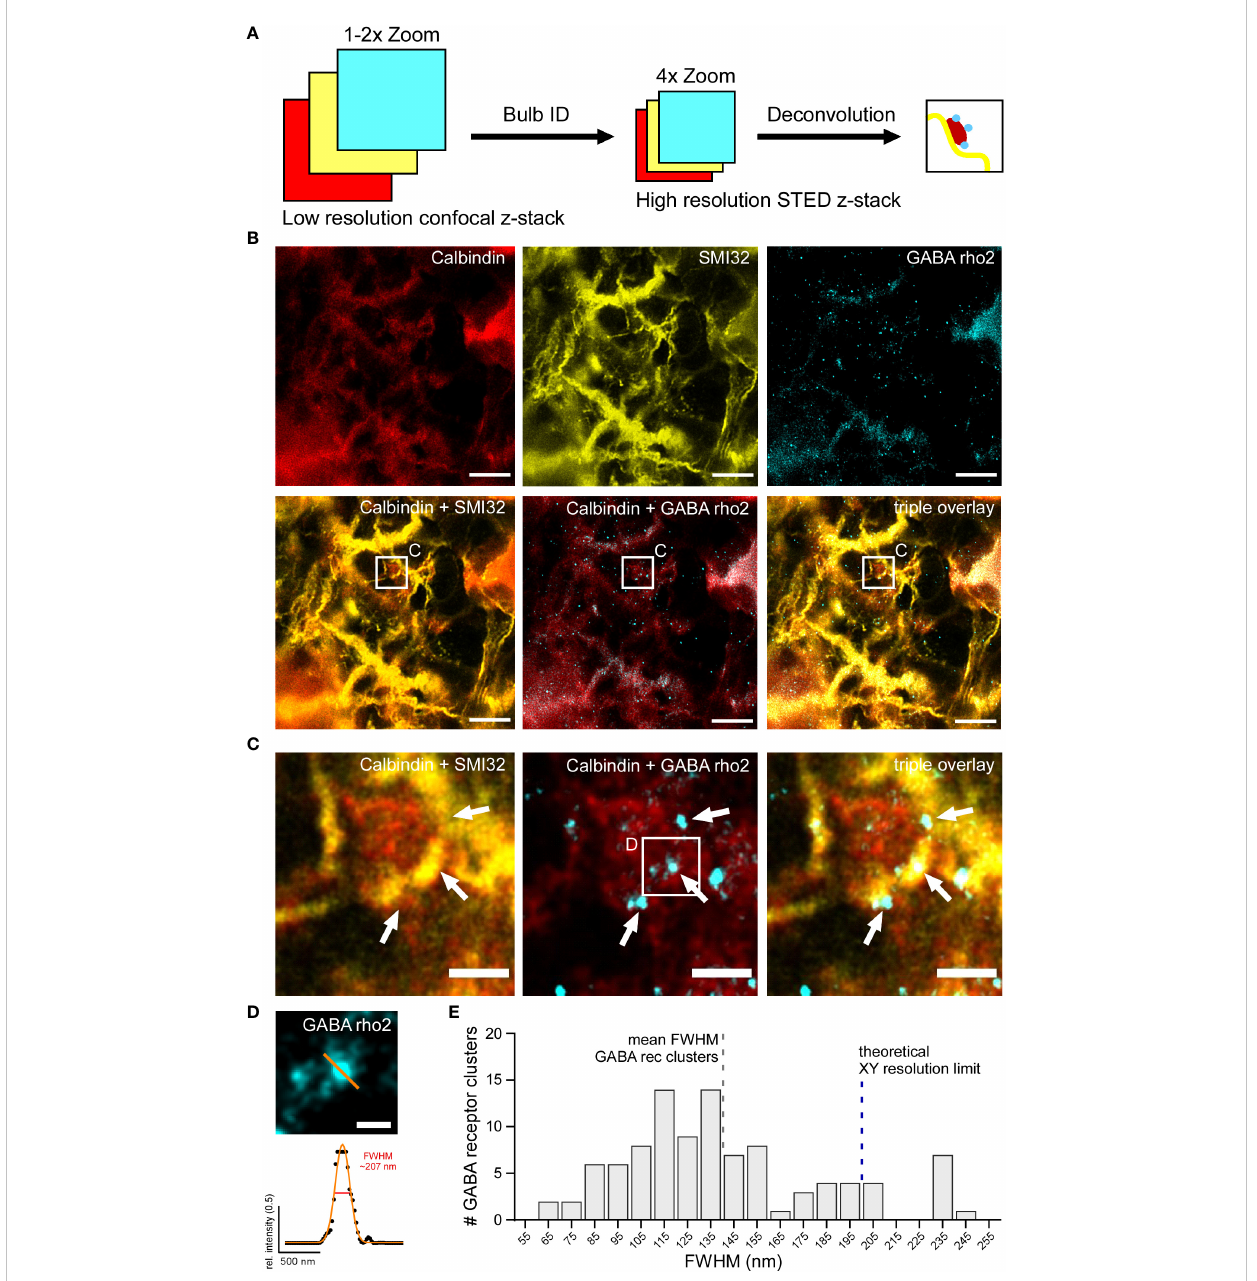
FIGURE 8 GABA C receptor clusters can be localised on horizontal cell dendritic bulbs with high-resolution STED (A) Schematic showing experimental design to image dendritic HC bulbs with high-resolution STED microscopy. Individual bulbs are identi fi ed in sections of large confocal z-stacks (Bulb ID, see also Figure 3). Bulbs were zoomed into, imaged as STED z-stacks and visualised using maximum z-projections and deconvolution. (B) Triple staining experiment against Calbindin (red), SMI32 (yellow) and GABA r 2 (cyan) showing a dendritic bulb (white square) imaged in the STED mode. The centre of the bulb is negative for SMI32 but positive for calbindin labelling. White square indicates the position of the bulb depicted as close-ups in C. (C) Zoomed-in bulb with triple staining against Calbindin, SMI32 and GABA r 2 showing a HC dendritic bulb (from white square in B) imaged in STED mode and deconvolved. Note that GABA r 2 receptor clusters (arrows) are located at the edges of bulb. (D) Example r 2-positive GABA receptor cluster (top, small white square from C) with Gaussian fi t and FWHM (bottom). FWHM intensity pro fi le is taken at the indicated position (orange line). (E) Histogram showing distribution of FWHMs of GABA r 2 clusters (in 10 nm bins) (n = 1 animal, n = 100 clusters). Dashed blue bar indicates xy resolution limit for confocal light microscopy (~ 200 nm), dashed grey bar shows FWHM mean for GABA receptor clusters (~ 140 nm, see Results section). For SMI32, the excitation wavelength was 532 nm, and the dye was ATTO532. For Calbindin, the excitation wavelength was 488 nm, and the dye was STAR488. For GABA r 2, the excitation wavelength was 635 nm, and the dye was ATTO633. Scale bars: 5 µm in B, 1 µm in C, 0.25 µm in